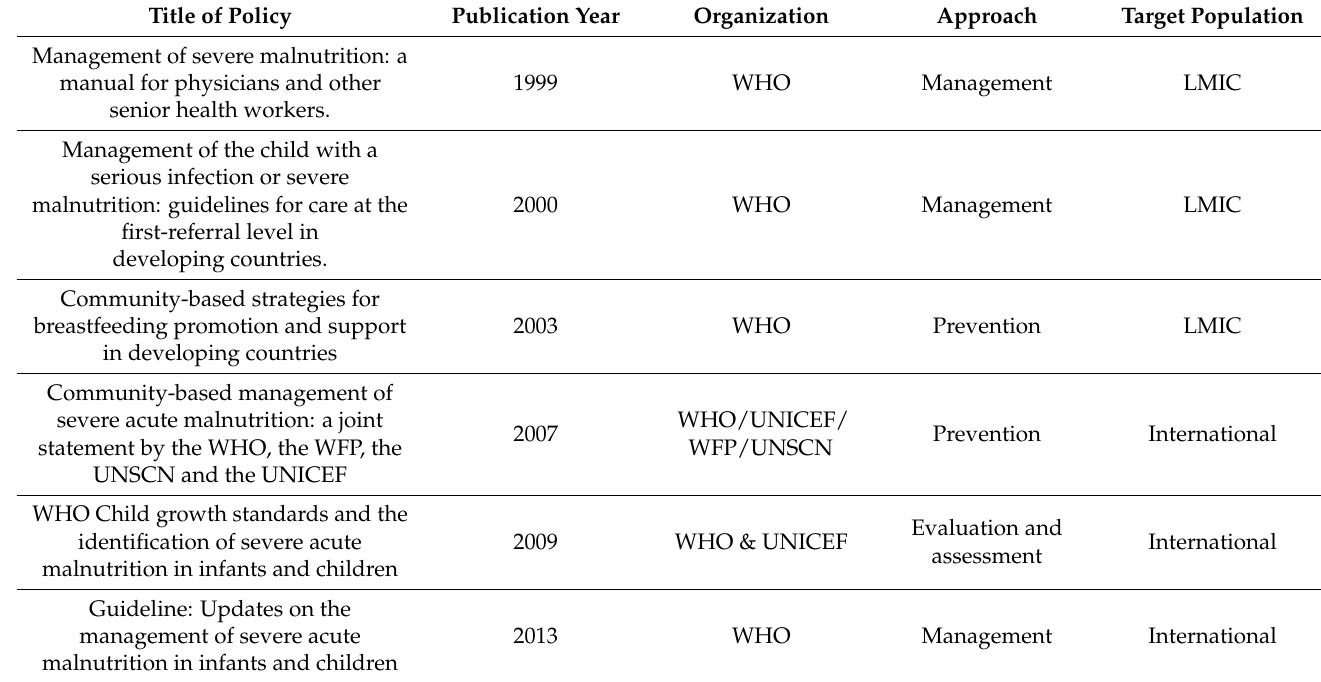
Table 1. Acute malnutrition management